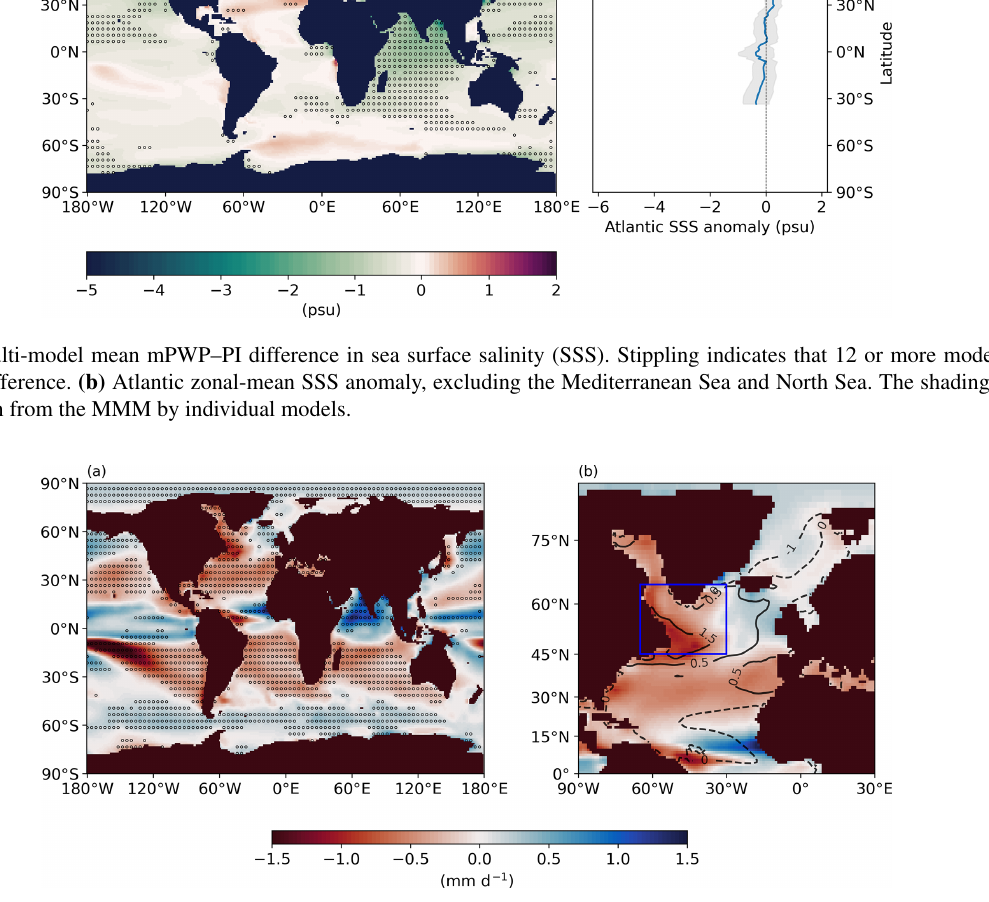
Figure 6. (a) Multi-model mean mPWP–PI difference in surface freshwater flux. Stippling indicates that 12 or more models agree on the sign of the difference. (b) Shading shows the MMM mPWP–PI difference in surface freshwater flux in the North Atlantic. Black contours show the MMM mPWP–PI sea surface salinity anomaly. The approximate extent of the negative PmE anomaly over the Labrador Sea and subpolar North Atlantic is indicated in (b) by the blue box (45–65 ◦ N, 30–60 ◦ W). A negative PmE anomaly means that evaporation is higher than